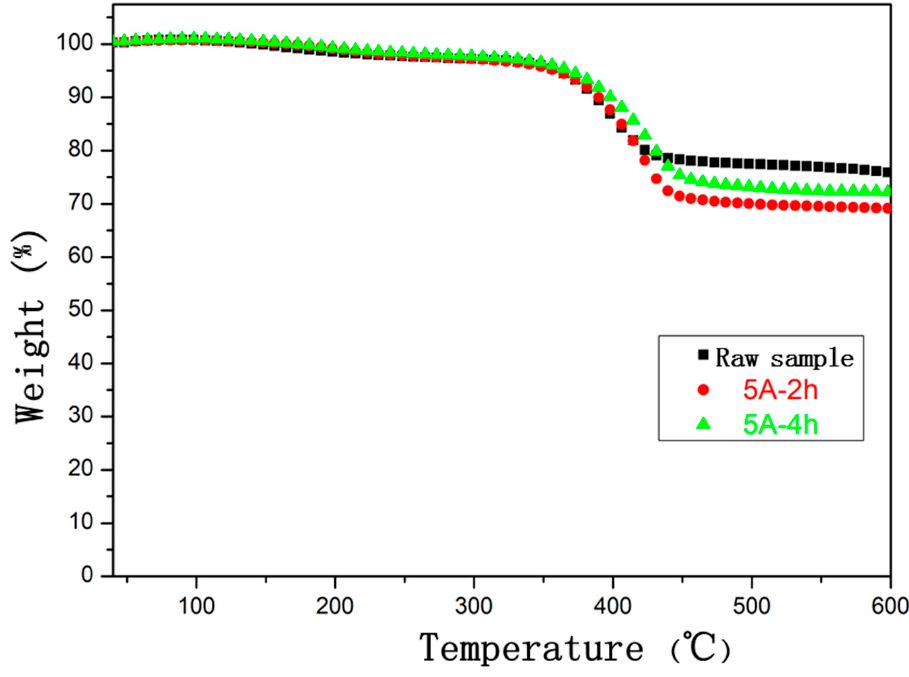
Figure 9. TGA curves of CFRE composites before and after electrothermal treatment.